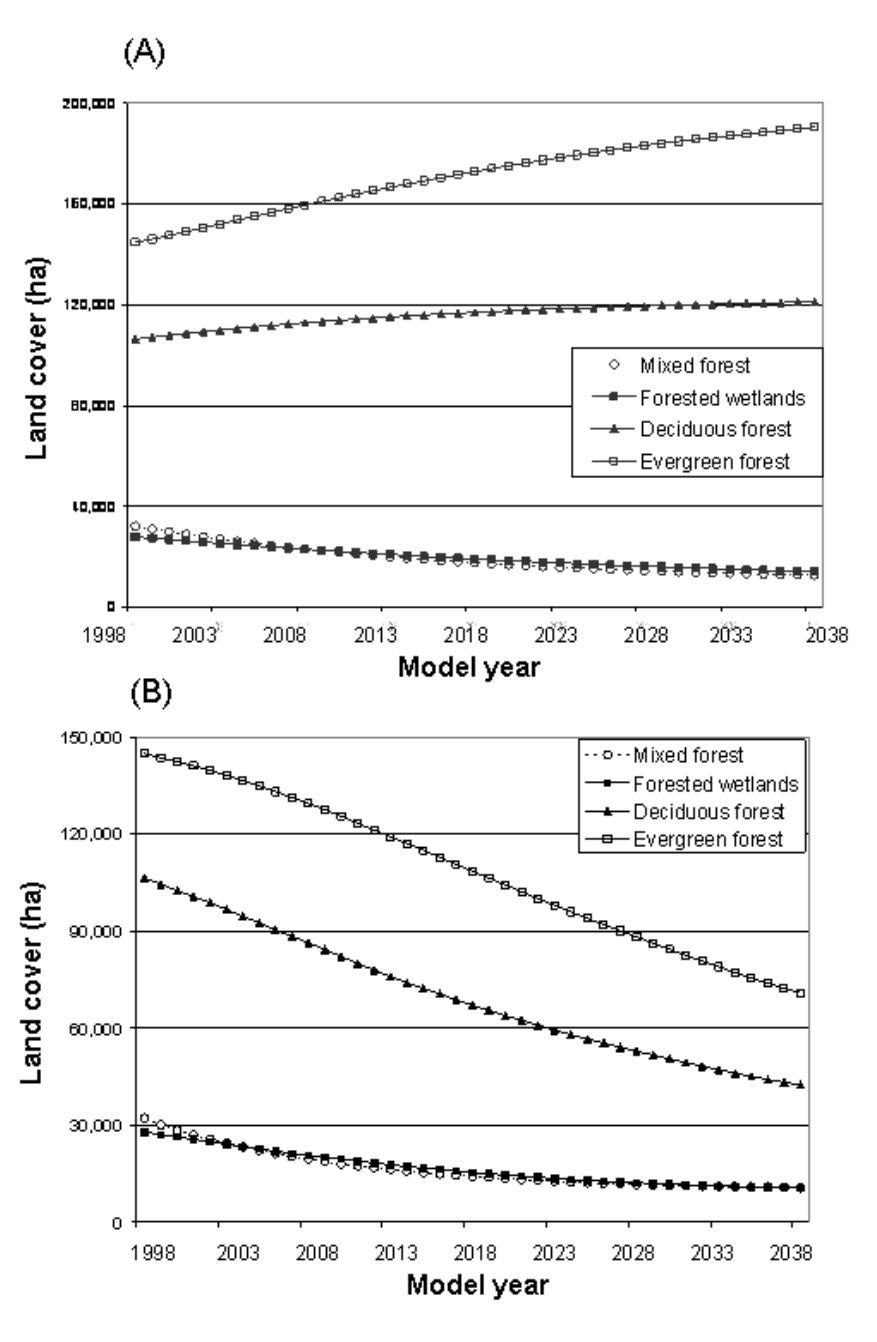
Fig. 5. Projected changes in forest cover over 40 yr for the (A) business as usual scenario and (B) high urban growth